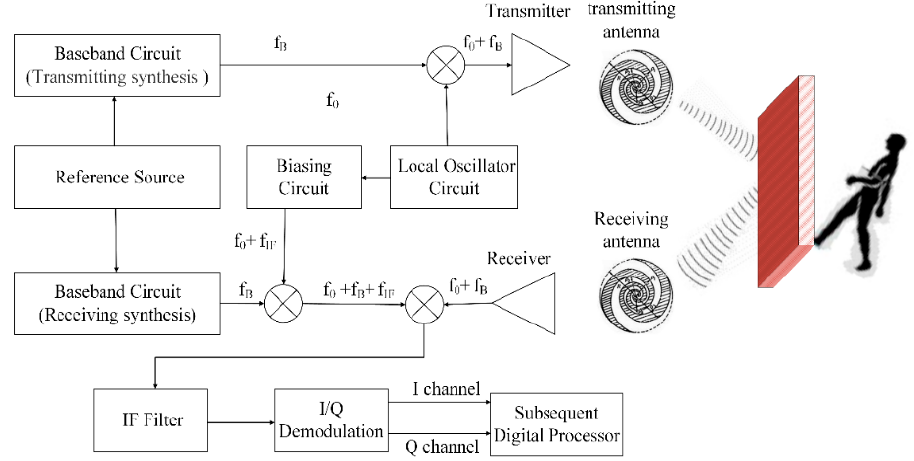
Figure 1. Schematic diagram of the SFCW radar system.